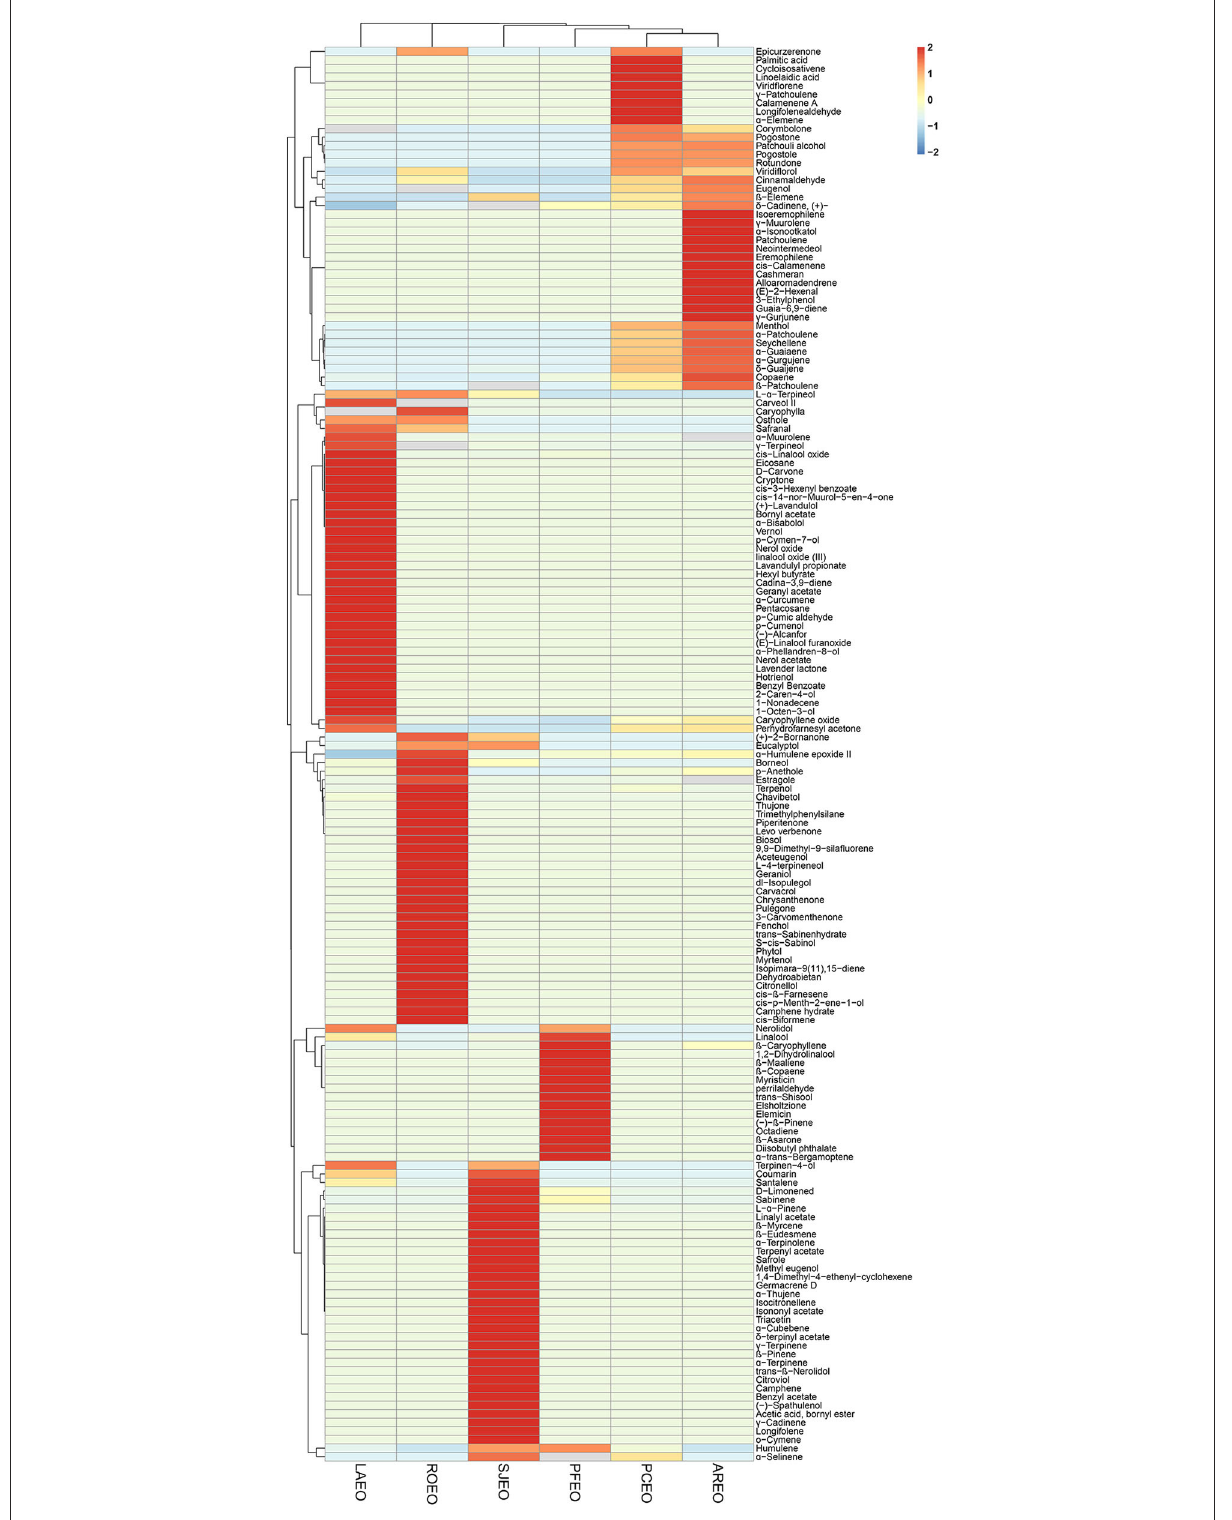
FIGURE1 Hierarchical cluster analysis for the chemical compositions in six essential